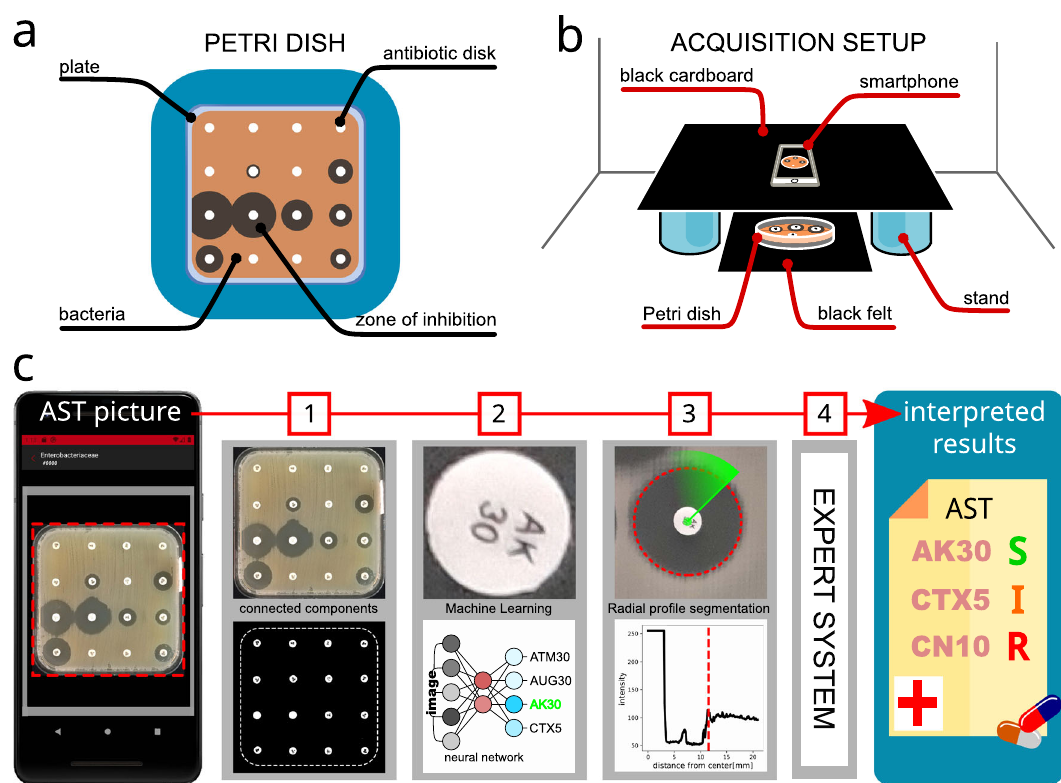
Fig. 1 Analysis of an AST plate with the App. A prepared and incubated Petri dish ( a ) is positioned in a simple image acquisition setup made of cardboard ( b ), we used two containers available in the laboratory as stands. A picture of the plate is taken with a smartphone and the analysis follows the work fl ow described in ( c ): the Petri dish image is cropped and the antibiotic disks are found (c1); the image of each antibiotic disk is fed to a ML model that identi fi es the antibiotic (c2); the diameter of the inhibition zone is measured (c3) with an original algorithm. Finally, the Expert System uses the diameters to output interpreted results